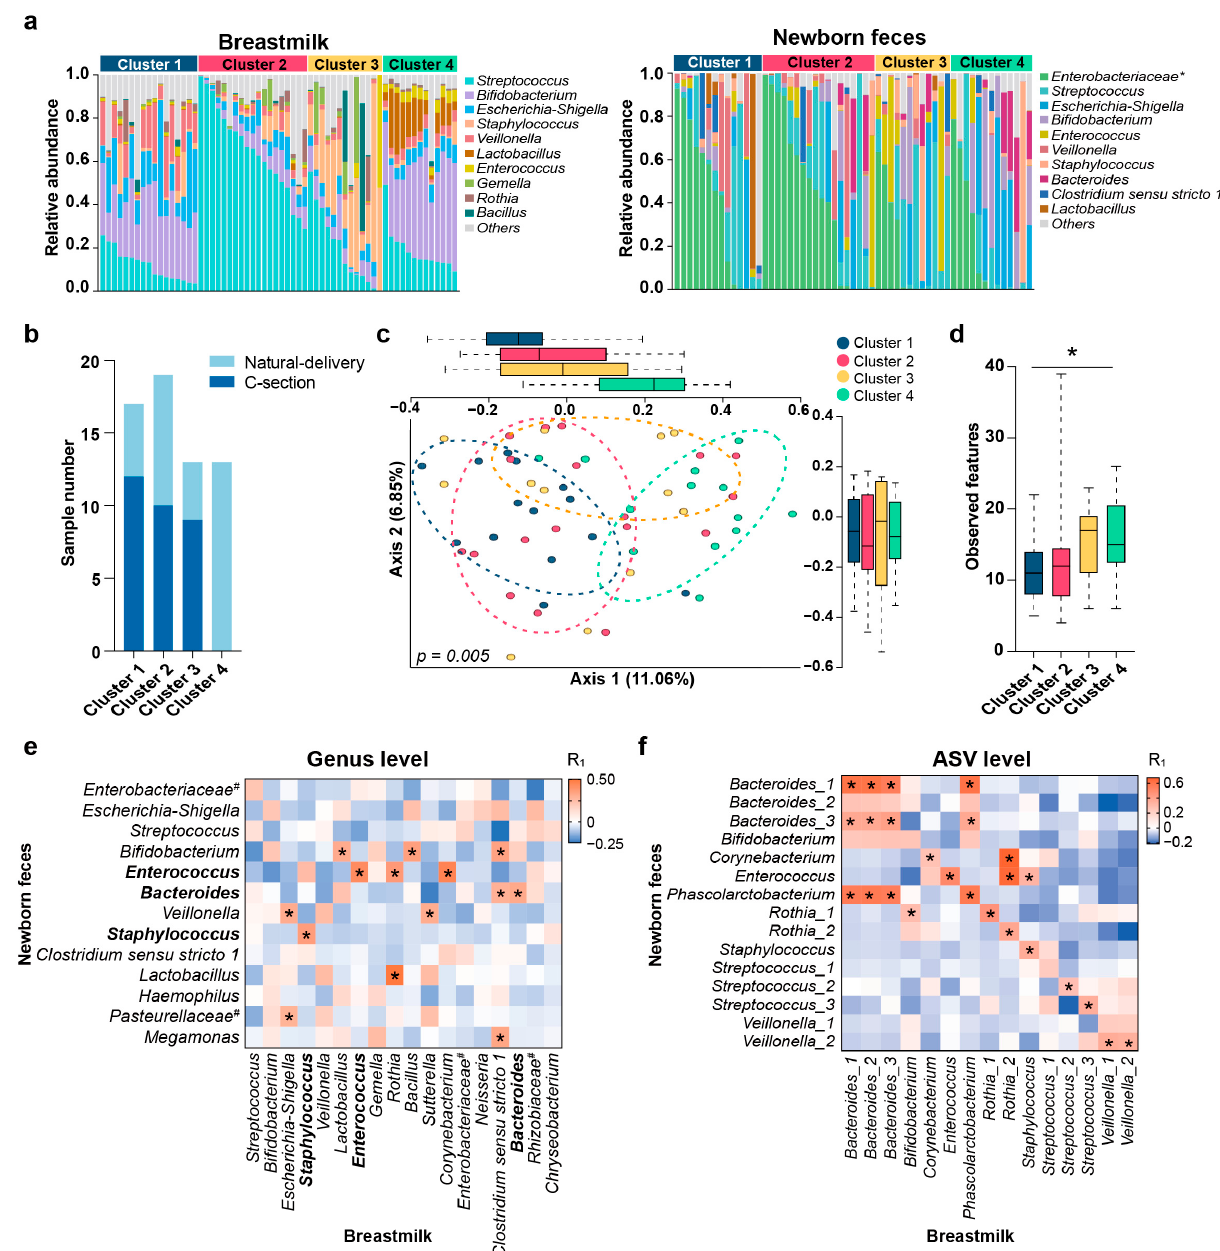
Figure 1. Breastmilk bacteria are correlated with newborn gut microbiota in the first week of lactation. ( a ) Taxa-bar plot of mean relative abundance of neonatal breastmilk microbiota and gut microbiota at the genus level. Top 10 genera in breastmilk or fecal samples are included. Bacteria other than top 10 are grouped as ‘Others’. ( b ) Number of newborns based on delivery mode in the four breastmilk microbial clusters. ( c ) PCoA plot based on Jaccard distance of the neonatal gut microbiota corresponding to the four breastmilk microbial clusters. ( d ) Boxplots of alpha diversity calculated by observed features of the neonatal gut microbiota in the four breastmilk microbial clusters (Mann–Whitney U test followed by Bonferroni correction, * p < 0.05); ( e , f ) Heatmap of partial correlation analysis between breastmilk microbiota and newborn gut microbiota at the genus level ( e ) and the ASV level ( f ). Bacteria with relative abundance >1% are included. Asterisks (*) in heatmap mean significant correlation (|R 1 | > 0.2 and p < 0.05). Pound sign (#) indicates the unclassified bacteria at the genus level. Genera in the abscissa are members of breastmilk, and genera in the ordinate are the bacteria of newborn gut microbiota.